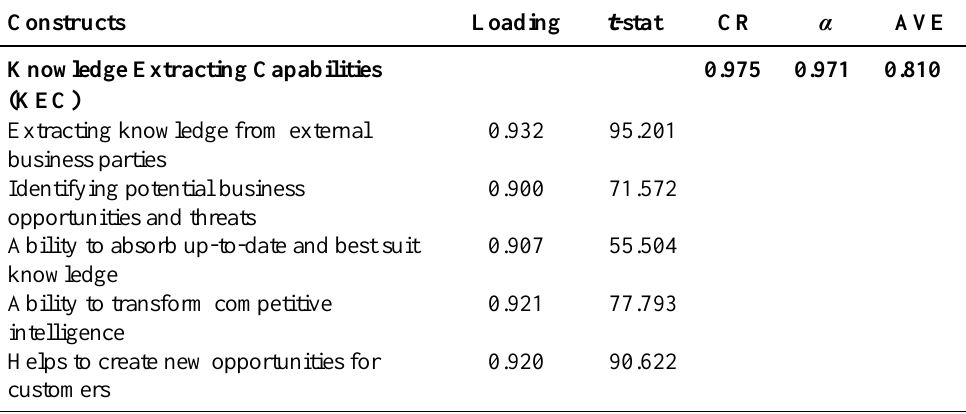
Table 3: Reliability and Validity of Second-Order